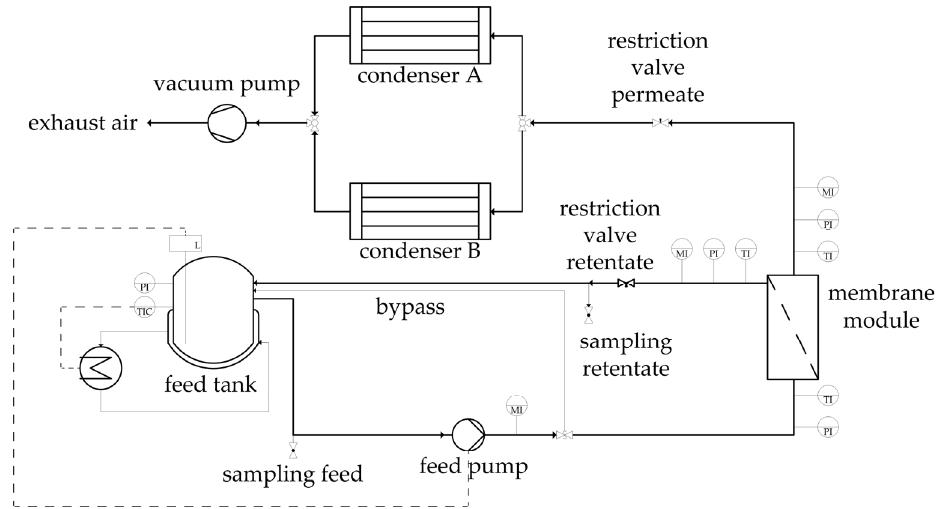
Figure 5. Flowsheet of the pervaporation unit utilized for the binary and ternary experiments. Table 2. Experimental design for the binary system ethanol/water. Indicated (*) experiments represent the centre point experiments. Bold highlighted experiments were used for the determination of the permeance, the rest for the validation of the model. All experiments were conducted with feed pressure of 3.5 bar.